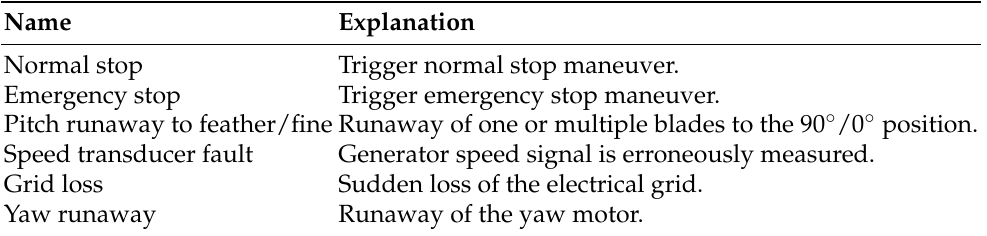
Table 3. Events included in the event